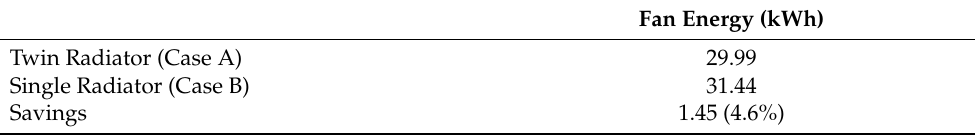
Figure 6. Radiator fan power consumption for twin- and single-radiator configurations. Table 2. Fan energy requirement for the two configurations integrated over the entire test cycle. Fan Energy